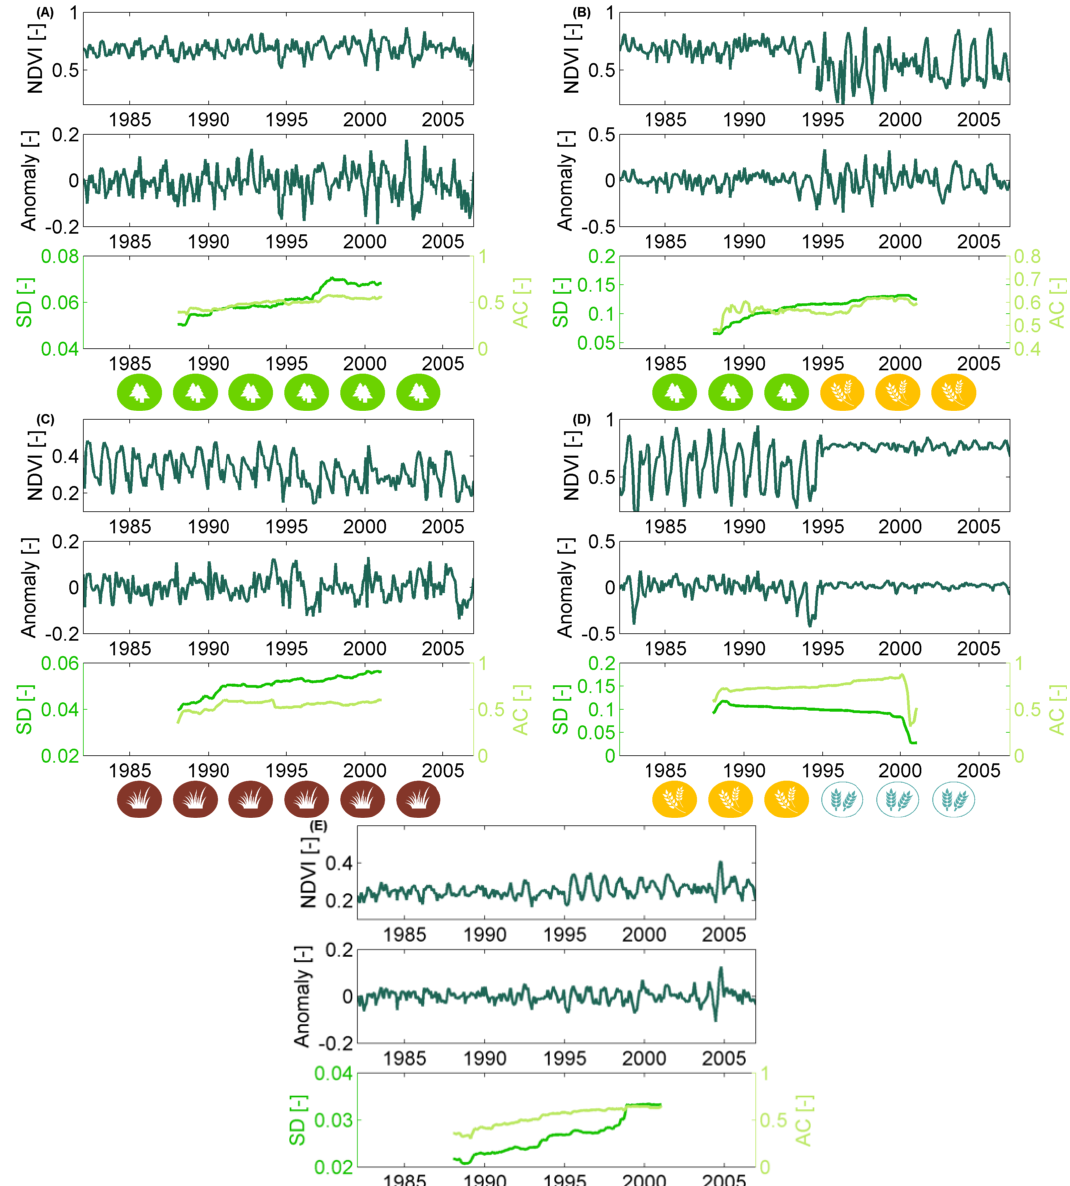
Figure 3. Proof of concept: illustration of potential causes of stability change using simulated time series. The case ( A ) illustrates the Normalized Difference Vegetation Index (NDVI) response (top panel) of a forest showing an increased vulnerability to disturbances. The increased vulnerability is reflected by an increased variance and slower recovery rate (bottom panel; characterized respectively through the standard deviation (SD) and auto-correlation at lag 1 (AC) of the NDVI anomalies (center panel)). Similarly, the case in ( B ) illustrates the conversion of forest to cropland, the case in ( C ) shrubland subjected to a weakening monsoon, the case in ( D ) conversion from rainfed to irrigated pasture and the case in ( E ) increased rainfall in arid